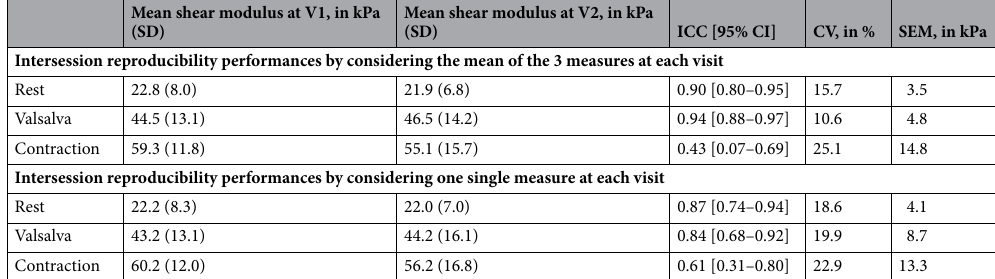
Table 1. Intersession reproducibility performances for the assessment of the right levator ani muscle’s shear modulus. ICC: Intraclass correlation coefficient, CI: confidence interval, CV: coefficient of variation, SEM: standard error of measurement, V1: first visit, V2: second